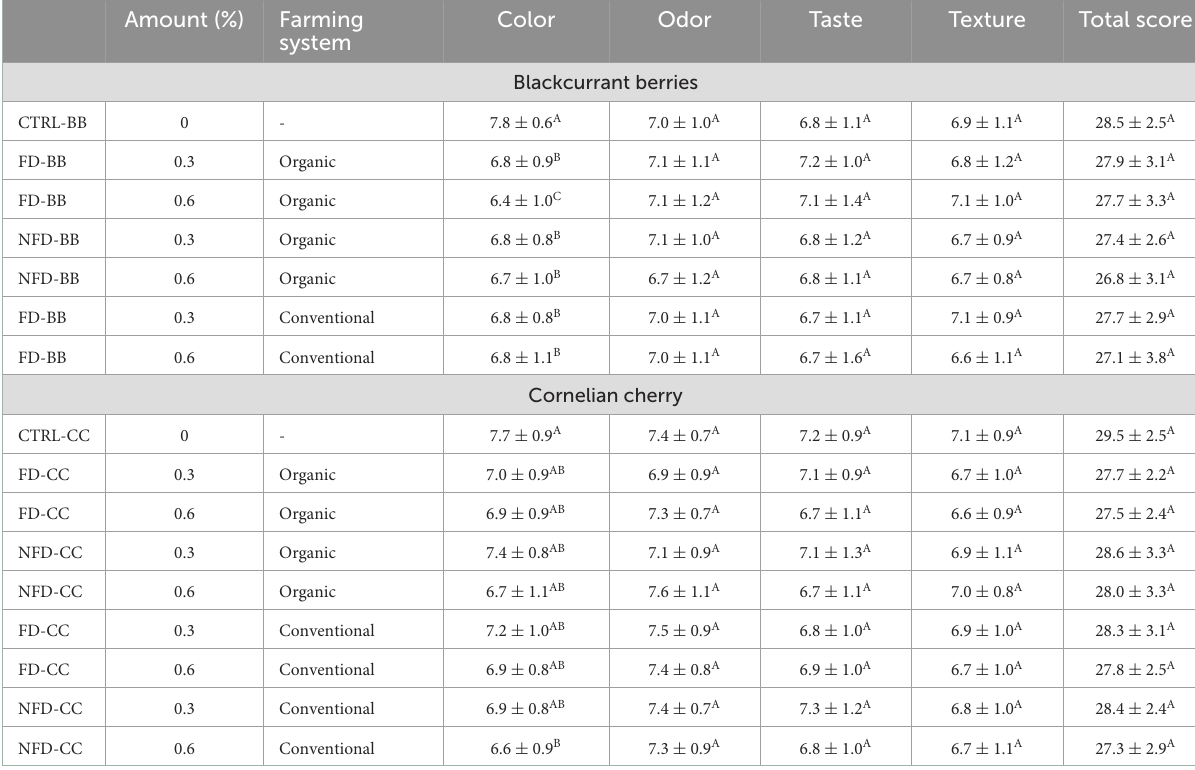
TABLE 4 Organoleptic evaluation of processed cheeses after 4 weeks of ripening, as affected by enrichment (blackcurrant or Cornelian cherry) dose of the enrichment (0.3 or 0.6%) and farming system (conventional or organic). Amount (%) Farming Color Odor Taste Texture Total score system Blackcurrant